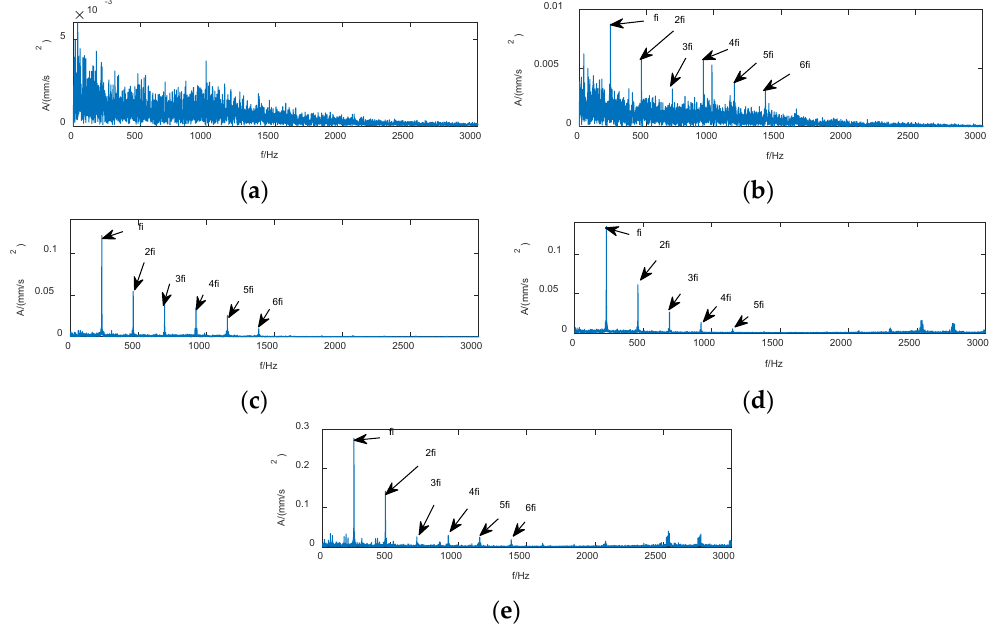
Figure 20. Envelope demodulation of key sample points; ( a ) 532nd data point; ( b ) 533rd data point; ( c ) 705th data point; ( d ) 850th data point; ( e ) 972nd data point.